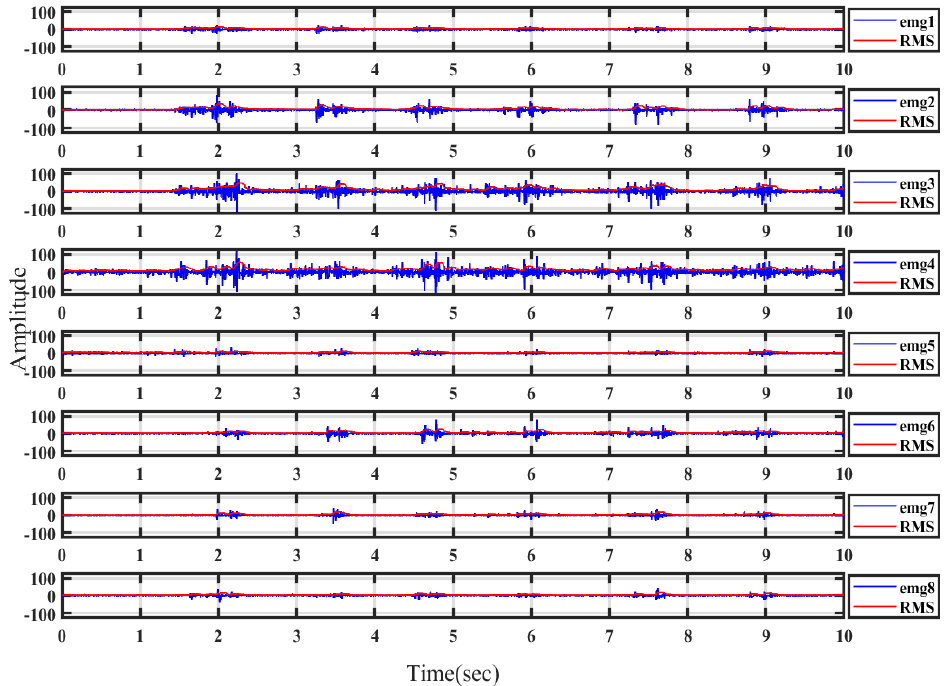
Figure 26. Gesture 5 (double-tap) performed six double taps in 10 s. The EMG signal and RMS graph of the eight sensors in the sEMG bracelet.